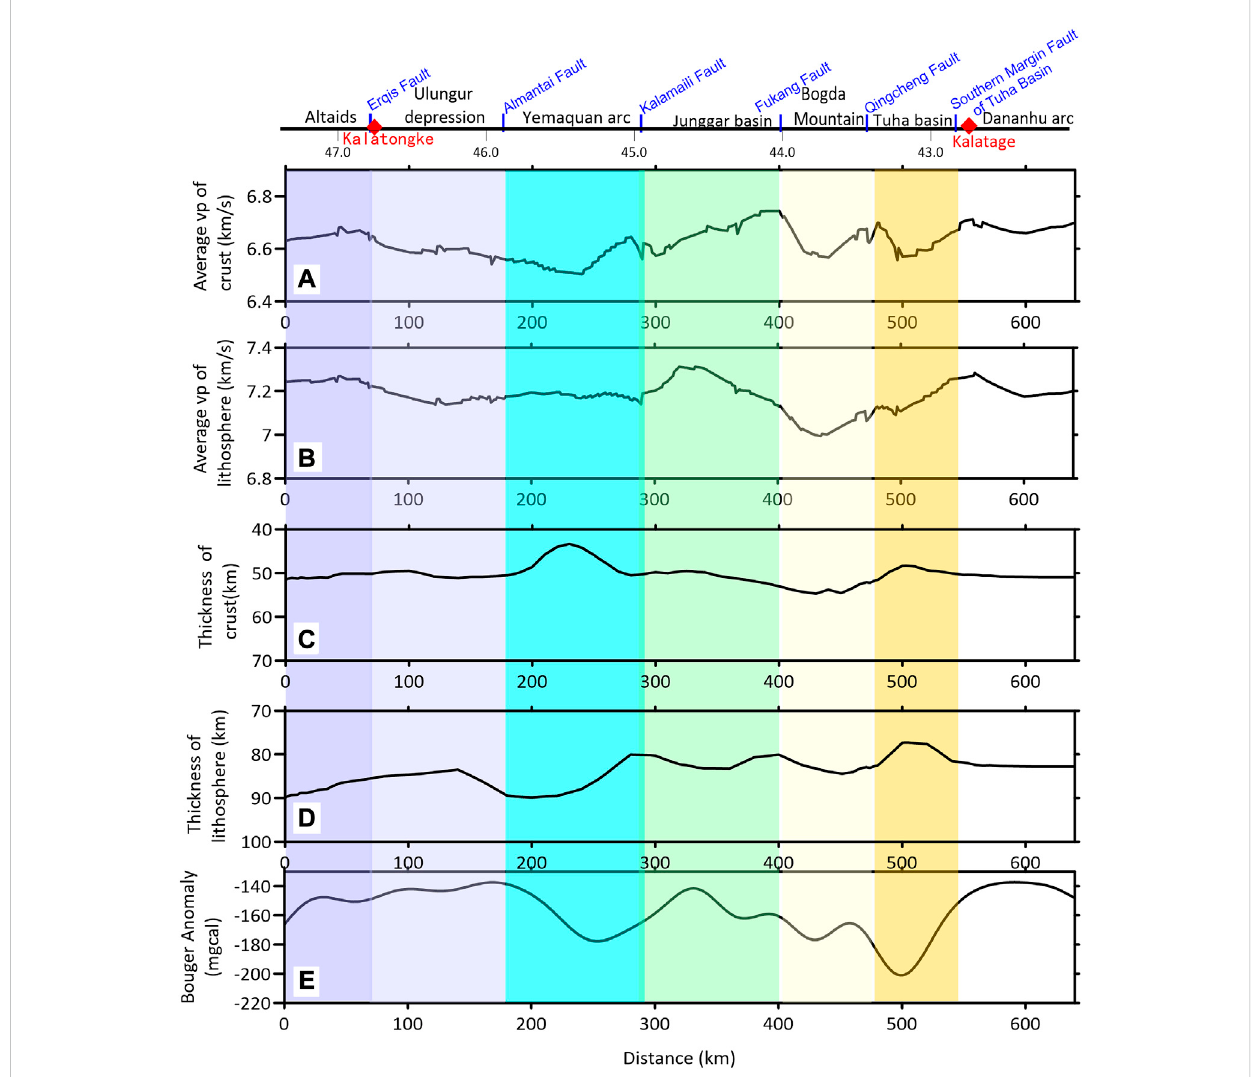
FIGURE 6 Physical parameters for different blocks (highlighted by vertical color bands) based on the fi nal P-wave velocity model. (A) Average Vp of the crust. (B) Average Vp of the lithosphere. (C) Thickness of the crust. (D) Thickness of the lithosphere. (E) Bouguer gravity anomalies along this pro fi le (extracted from the XGM2019 gravity fi eld model obtained by the Technical University of Munich in 2019). Top: structures and faults traversed by the reference pro fi le; red diamonds mark the location of the Kalatongke and Kalatage mineral deposits to the north and south of the pro fi le,